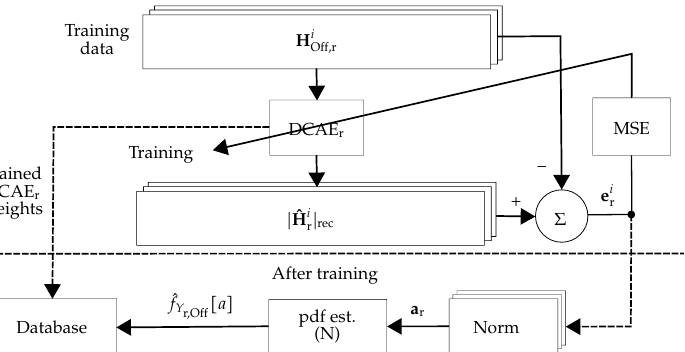
Figure 3. Schematic view of the offline phase of decentralized processing: In the offline phase of the r -th receiver, DCAE r is trained. Then, the pdf approximation of the anomaly score ( ˆ f Y weights of the trained network (DCAE * r ) are stored in the database.